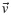
Panel a). In red, the average velocity field of the products on the RCLP, v→. Average velocities always point toward the asymptotic zone, marked by the orange line, which is calculated by finding the per-column minima of the velocity field after applying a kernel regression on the field. The result of a bootstrap, in orange, indicates the 5% confidence interval on the values. v→ indicates that points that stray away from the asymptotic zone tend to go back to it. Low velocities do not mean that products do not move, but rather that they move away from their box in all directions. The motion develops mainly across the vertical direction, with points randomly diffusing away from the asymptotic zone, and then moving back to it with regularity. Panel b). Average Herfindahl per box, i.e. the H field (in blue color), with its gradient calculated according to Eq 3 (green arrows). Higher values of H signal that there is less competition, on average, for products in that box. The blue line is a kernel regression of the minima of the Herfindahl field per column, with the blue colored area showing the 5% confidence interval on the value, calculated with a bootstrap. Notice its position is compatible with that of the velocity field minima. The H field acts in a way akin to a potential, as the products move towards its minima. This strongly suggests that changes in the vertical position of products is due to changes in the underlying markets. All the vectors in both panels are to 1:1 scale with each other and with the plot’s axes.